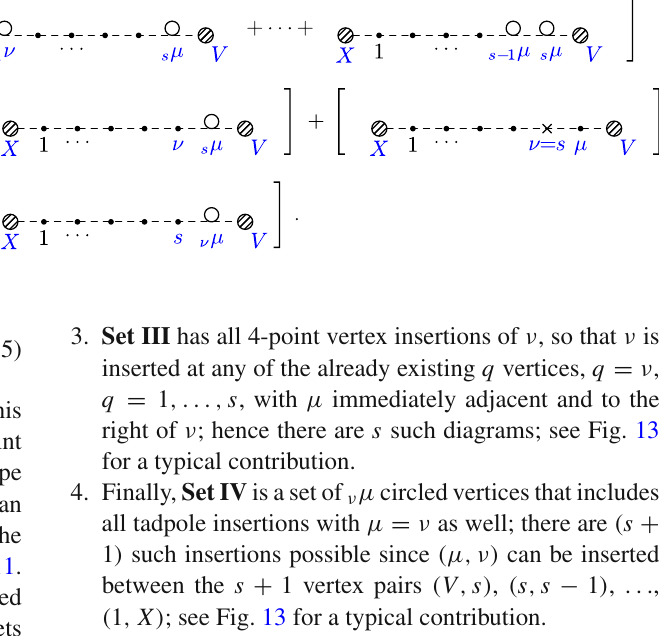
Fig. 12 The sum of the contributions from Sets A and B, shown in Figs. 10 and 11 above